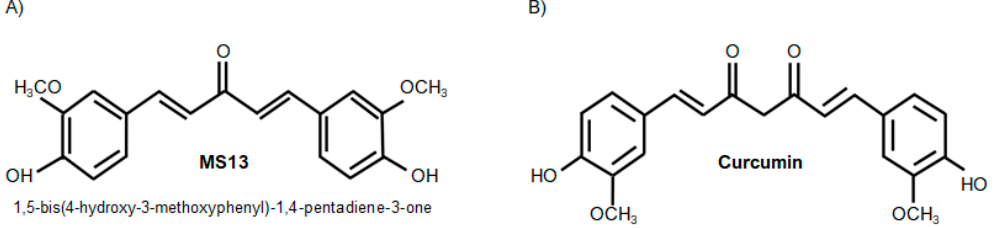
Figure 1. Molecular structure of MS13 ( A ) and curcumin ( B ).